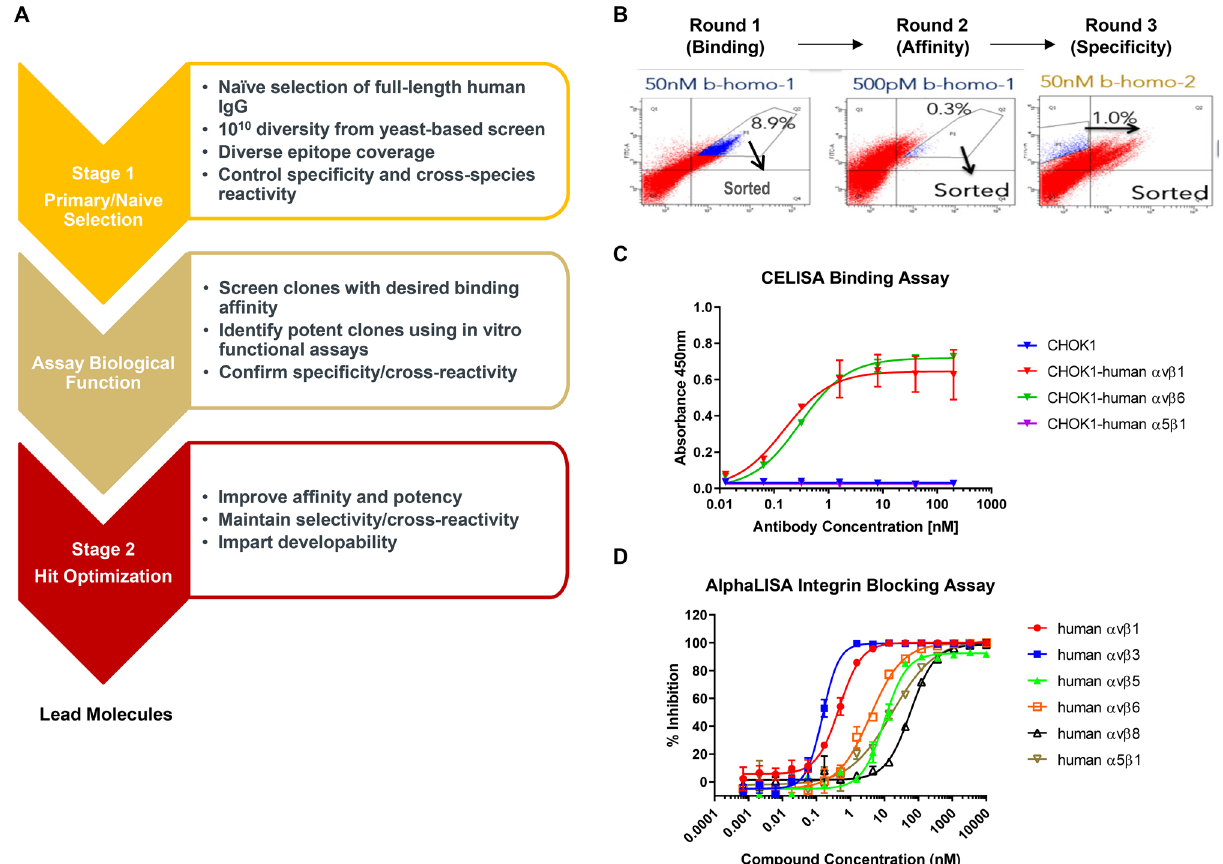
Figure 3. Integrin antibody screening and assay development. ( A ) Staged efforts to screen integrin antibodies from human naïve IgG library by using Adimab’s yeast display platform. ( B ) IgG-expressing yeast clone selection process. The X-axis represents integrin binding and the Y-axis reflects antibody expression. Yeast cell population with strong antigen binding (boxed) was sorted out for the next round of selection. ( C ) Cell-based ELISA (CELISA) binding assays were used as the primary screen for integrin antibody selection. Dose-dependent binding of the benchmarking integrin antibody mAb-24 to various integrin-expressing CHOK1 cells was shown. ( D ) AlphaLISA integrin-ligand binding assays were used for in vitro functional screen. Dose-dependent inhibition of human integrin-ligand binding by MK-0429 in AlphaLISA assay